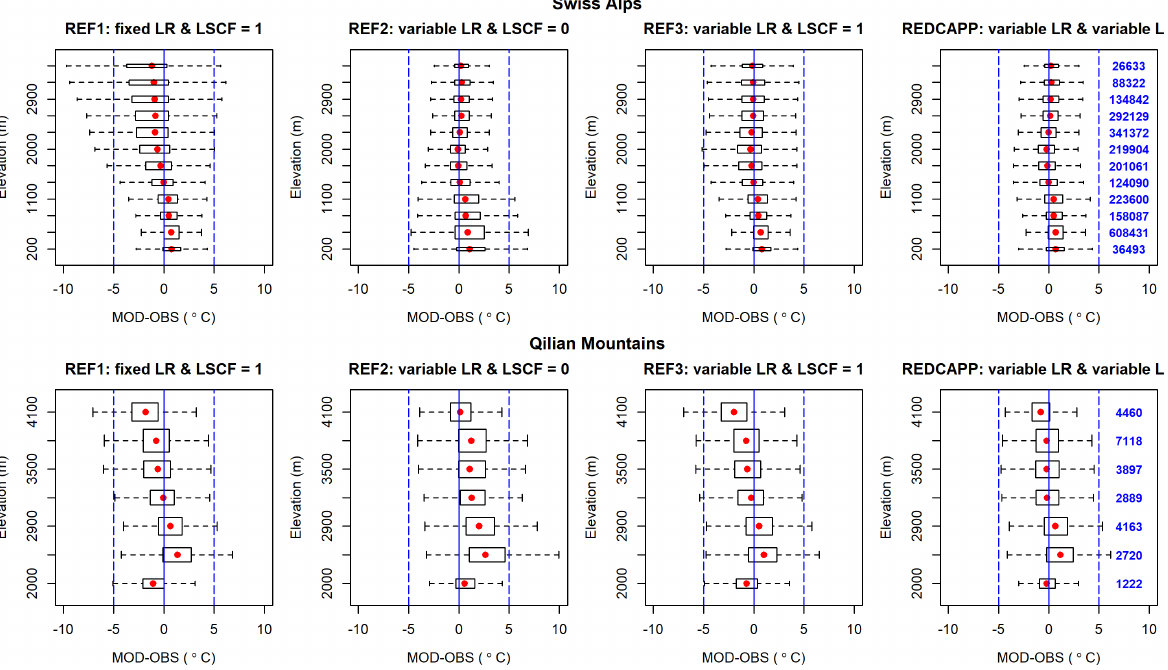
Figure 12. Deviances of downscaled results by elevations. The stations are grouped by elevation with an interval of 300m. Each box may contain multiple stations and the numbers of observation times (days) are given in blue on the right. Red dots are median